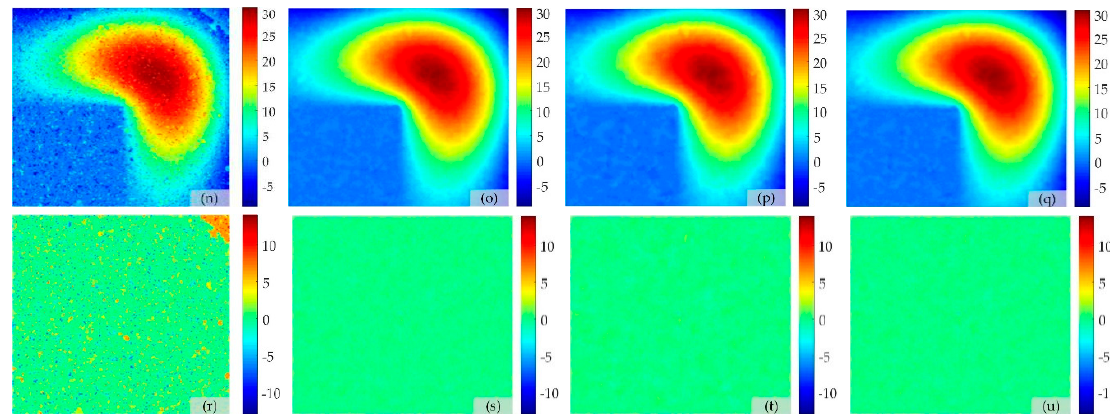
Figure 4. ( a ) Digital elevation model (DEM) for simulation data. ( b,c ) Reference unwrapped phases (( b ) long and ( c ) short baseline length). ( d,e ) Simulated wrapped phases of ( b,c ). ( f–i ) PU results of ( b ) obtained by ( f ) TSPA, ( g ) TSPAEKF, ( h ) TSPACKF, and ( i ) TSPAUIF. ( j–m ) Errors between ( b ) and PU results ( f–i ). ( n–q ) PU results of ( c ) obtained by ( n ) TSPA, ( o ) TSPAEKF, ( p ) TSPACKF, and ( q ) TSPAUIF. ( r–u ) Errors between ( c ) and PU results ( n–q ). Table 3. The results of different PU methods in Figure 4j–m,4r–u (unit: radians). Long Baseline PU Method